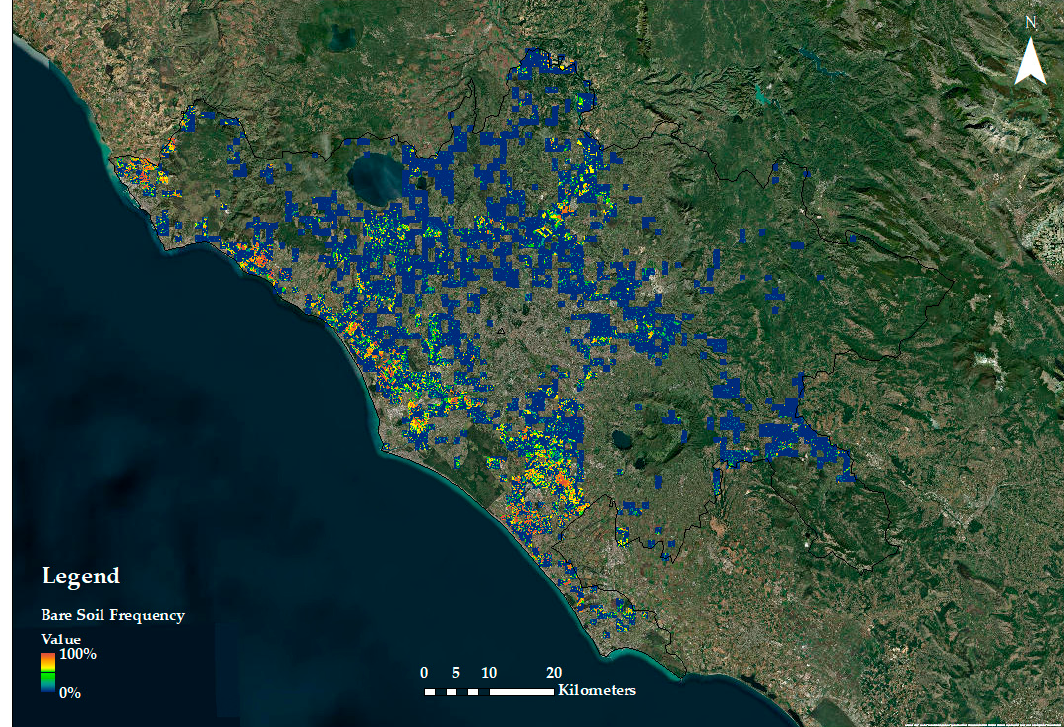
Figure 8. Bare soil frequency map of the Rome region for the month of September, average over the four years of data.